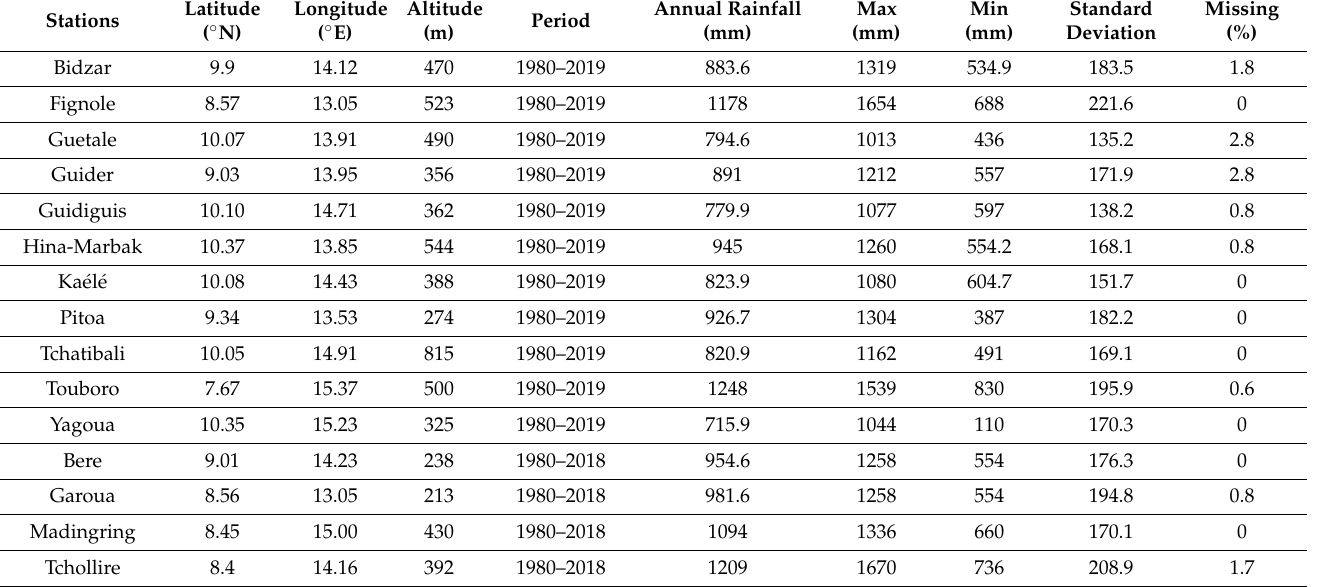
Table 1. Geographical descriptions of the data, altitude, period of measurement, and percentage of missing data.